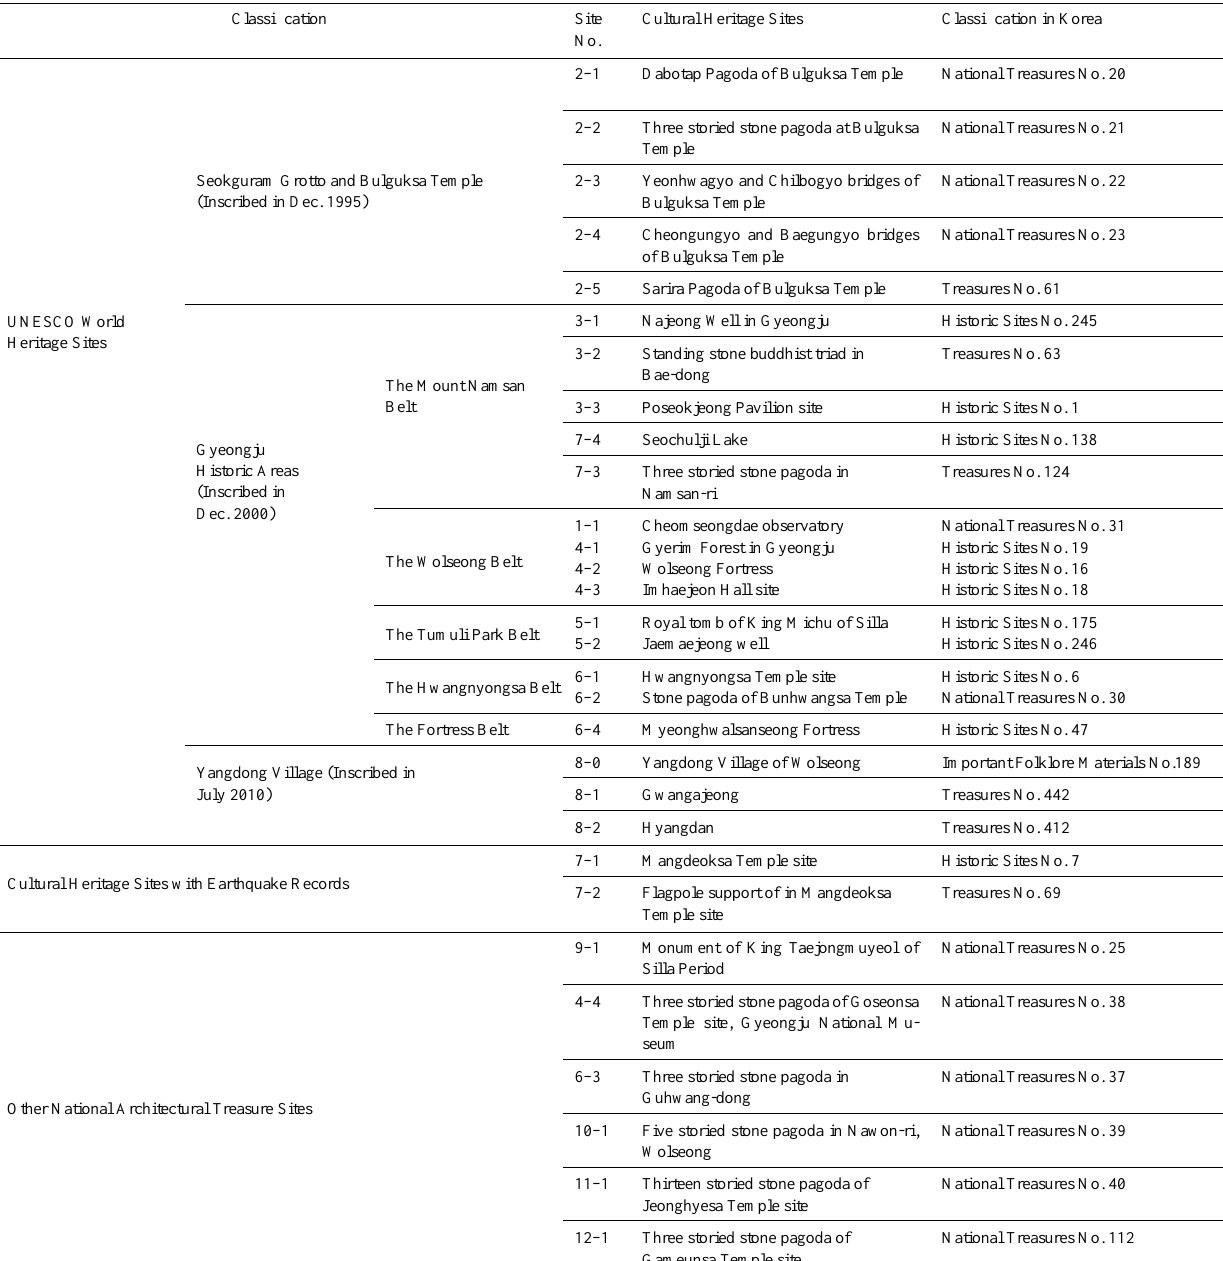
Table 2. Cultural heritage sites for in situ test and ground response analysis in